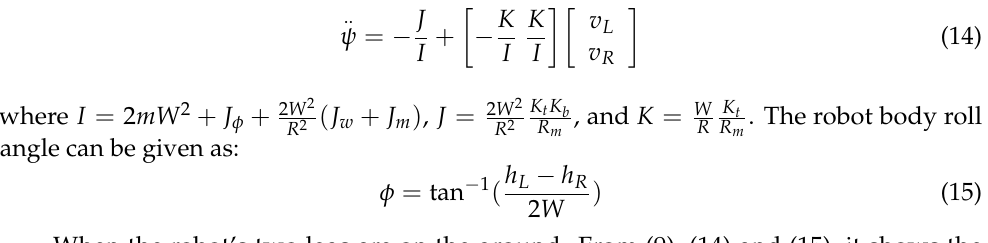
Figure 4. The block diagram of the IMBC system for the WBR.